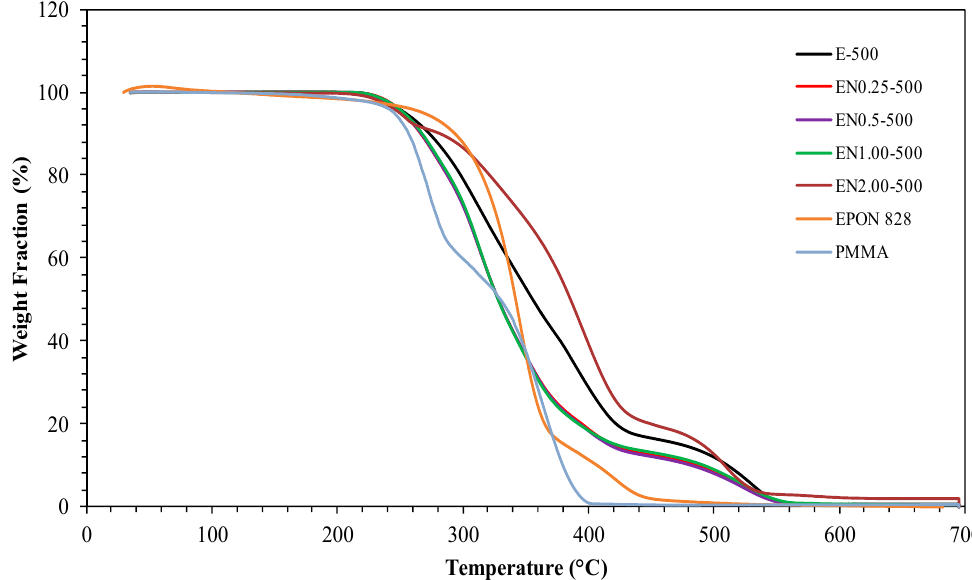
Figure 4. TGA thermographs of epoxy, PMMA, and PMMA microcapsules containing epoxy/CNT mixtures, under a nitrogen atmosphere at a heating rate of 10 °C min − 1 .